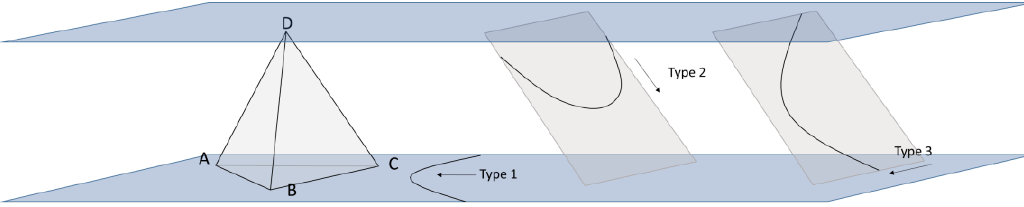
Figure 5. The schematic diagram of dislocation slip systems in nano-twinned Cu.